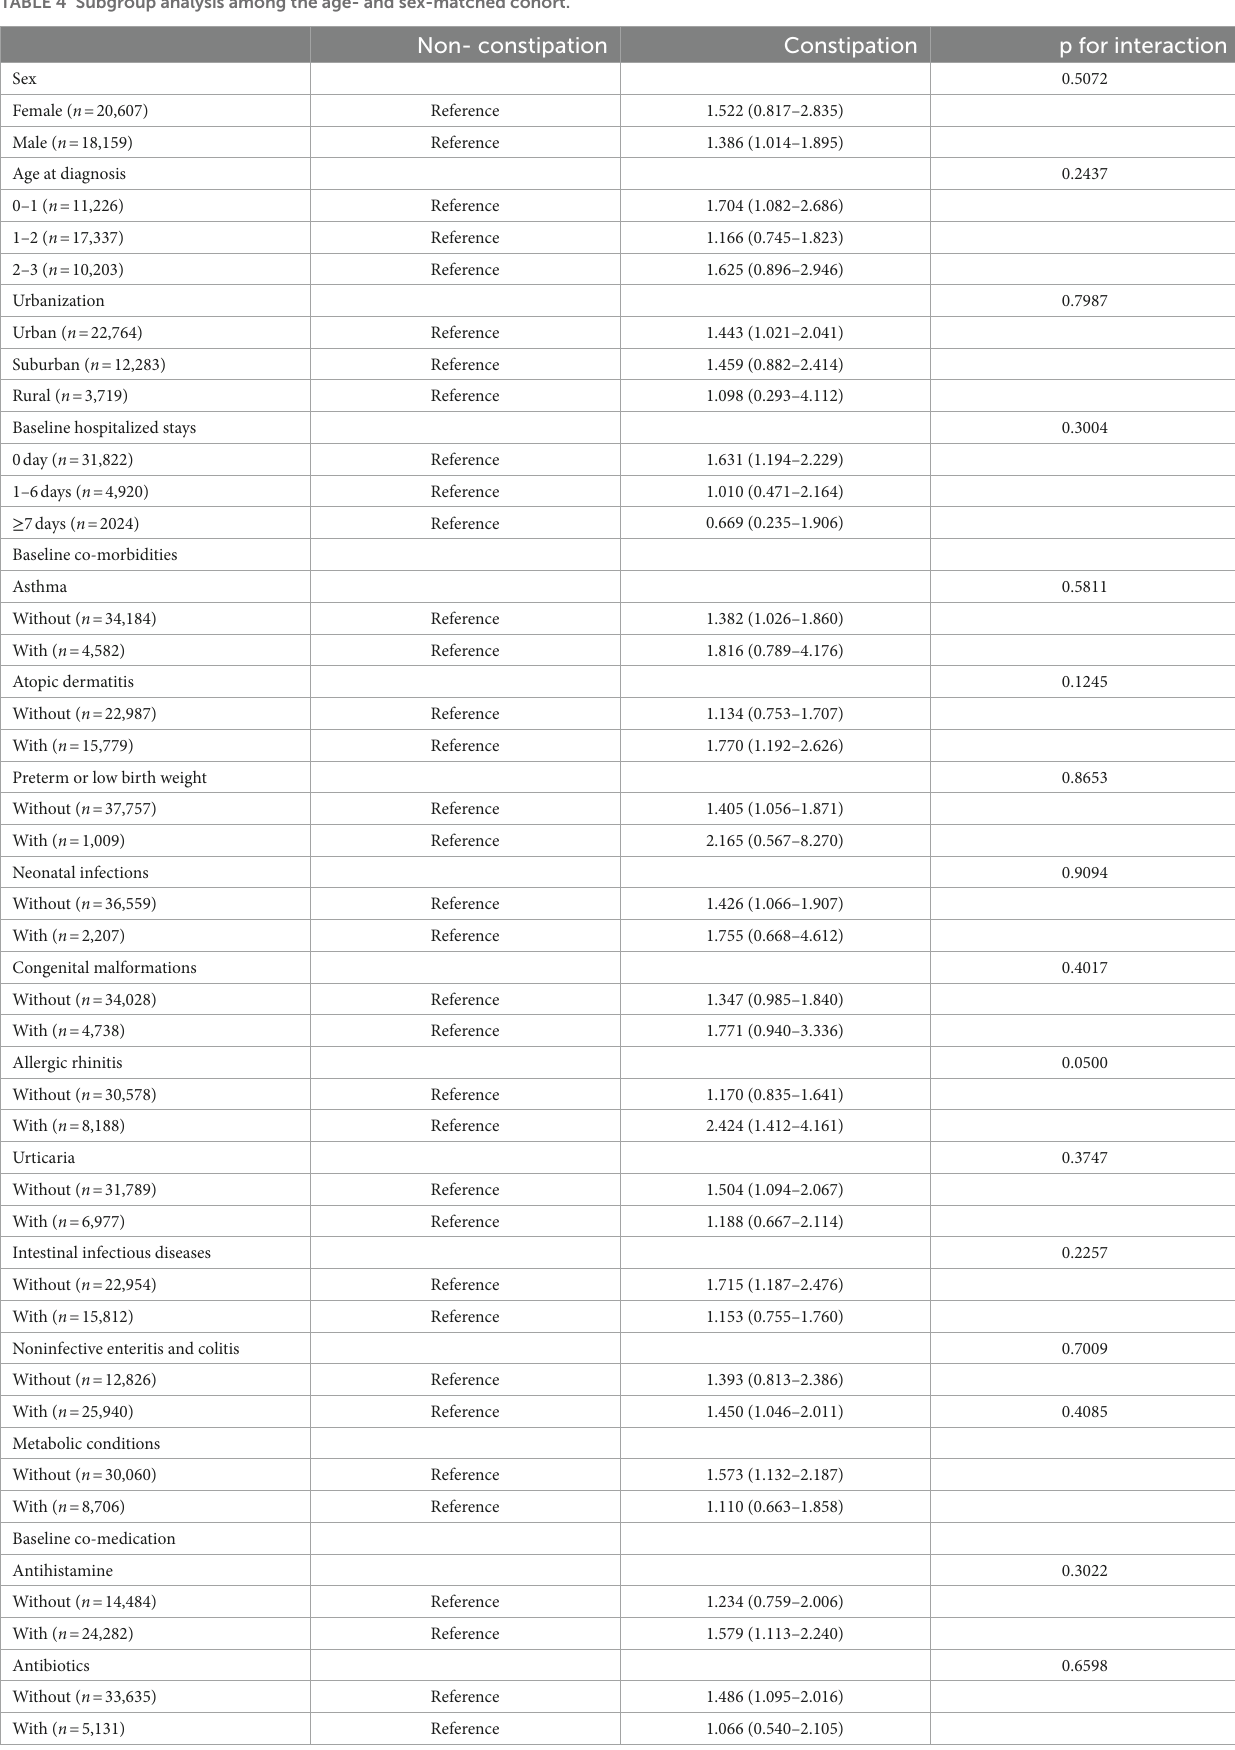
TABLE 4 Subgroup analysis among the age- and sex-matched